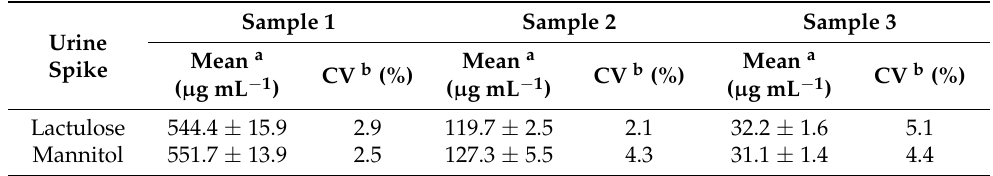
Table 3. Intra-assay variability of lactulose and mannitol in three urine samples each repeated 10 times within the same assay